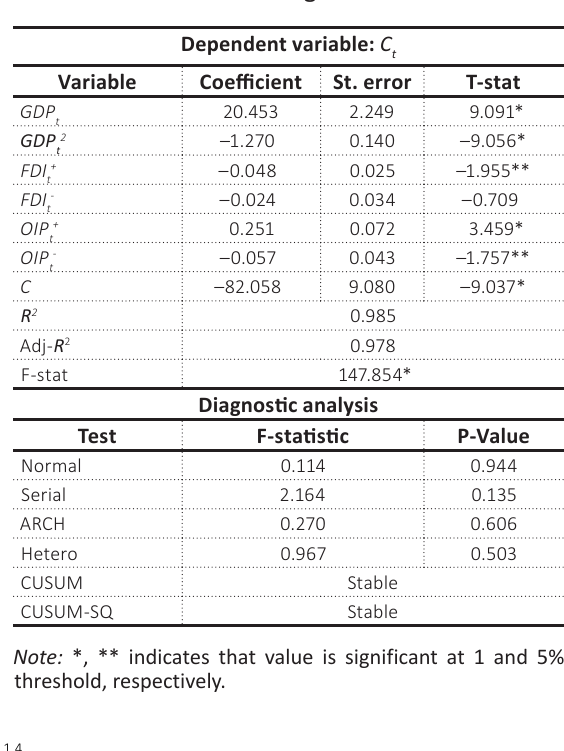
Table 6. NARDL model long-run results